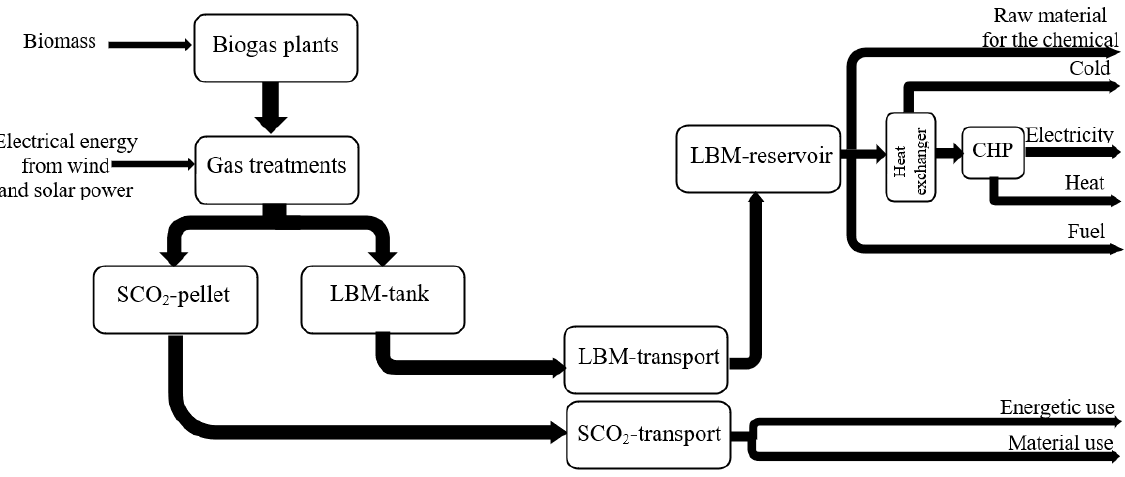
Figure 6. Potential applications of SCO 2 and liquid biomethane. CHP—combined heat and power; LBM—liquefied biomethane; and SCO 2 —solid carbon dioxide.